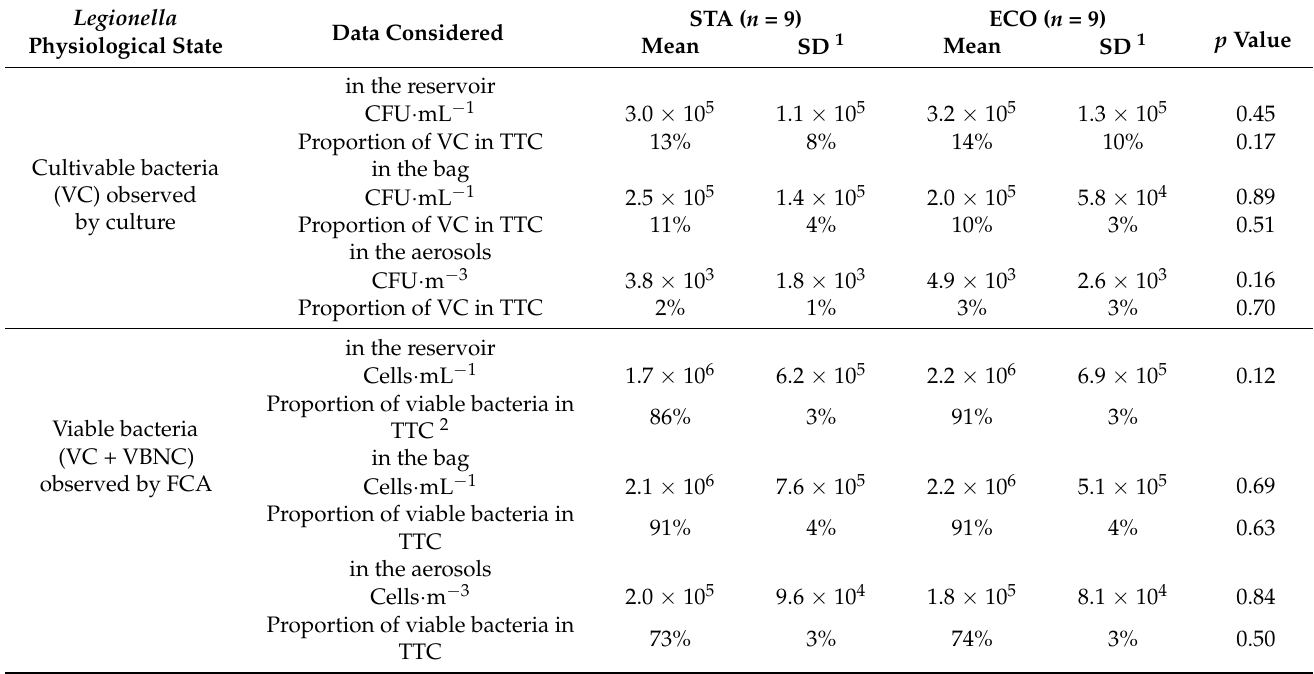
Figure 3. Variation in Total Cell Counted (TCC) of L. pneumophila in different samples when a “standard” (STA) or an “economic” (ECO) showerhead was used with an equal volume of water: ( a ) in the reservoir (Res.) and in the bag; ( b ) in the aerosols. The whiskers indicate the minimum and the maximum value, the box covers the values between the first and third quartile and the line in the box marks the median value. Table 2. Mean number and proportion of viable and cultivable populations of L. pneumophila for all combined samples obtained by culture and by flow cytometric assay